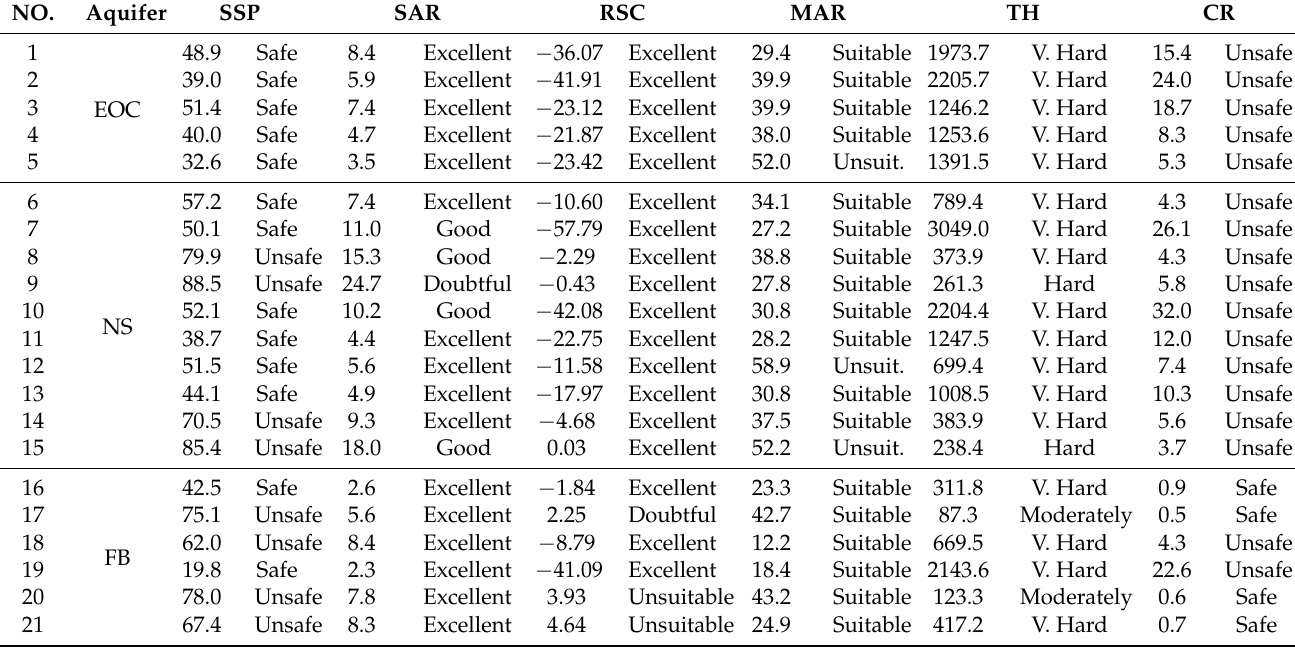
Table 4. Groundwater quality indicators for irrigation and domestic